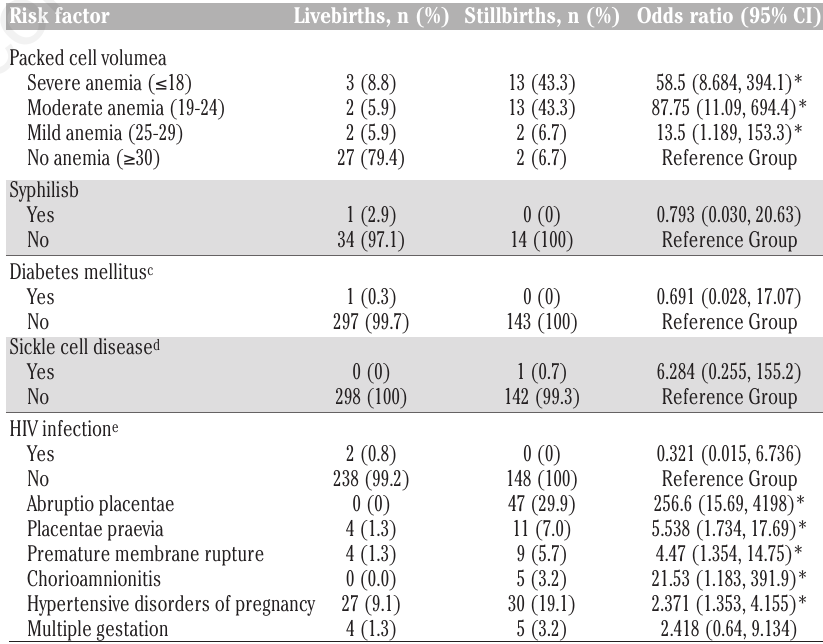
Table 2. Pre-natal determinants of stillbirths.